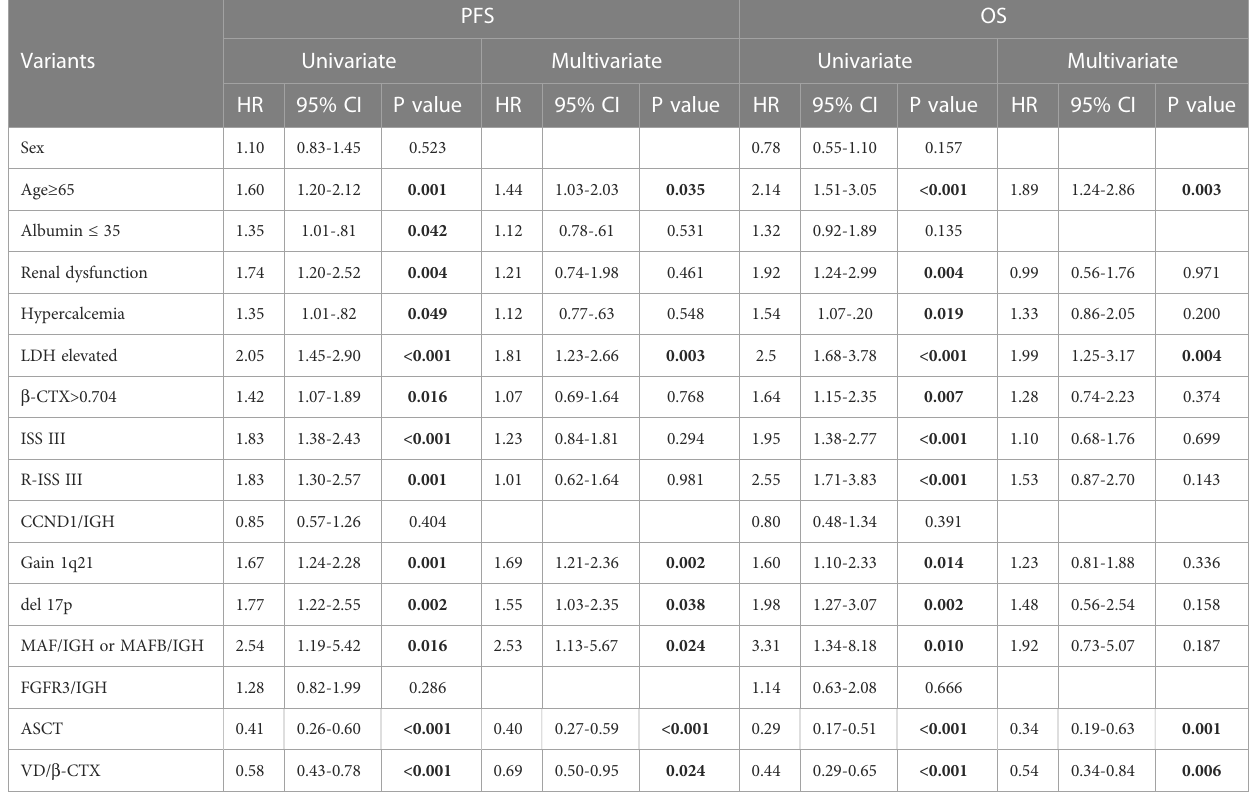
TABLE 2 Cox regression analysis for PFS and OS.